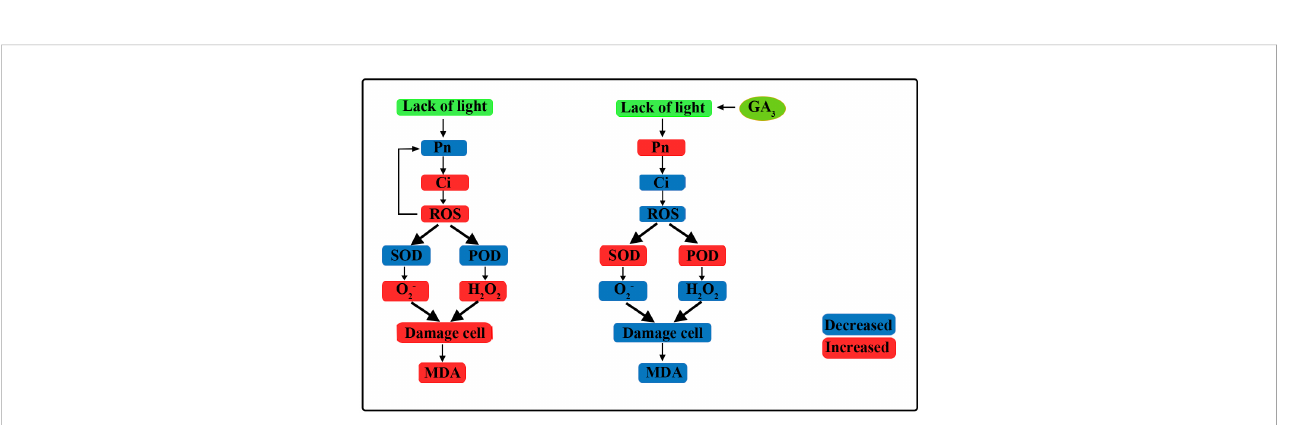
FIGURE 10 Overview of effects of exogenous GA 3 on plant photosynthetic physiology and reactive oxygen species (ROS) scavenging pathways. Under low light, the net photosynthetic rate (Pn) decreased, the intercellular carbon dioxide concentration increased, and the ROS content increased, which further affected Pn. Under low light, the activities of antioxidant enzymes decreased and the ROS scavenging rate decreased, thereby leading to cell damage and MDA was produced increase the degree of membrane lipid peroxidation. After the application of GA 3 , Pn improved, the activities of antioxidant enzymes increased, ROS scavenging was enhanced, cell damage was reduced, and the MDA content